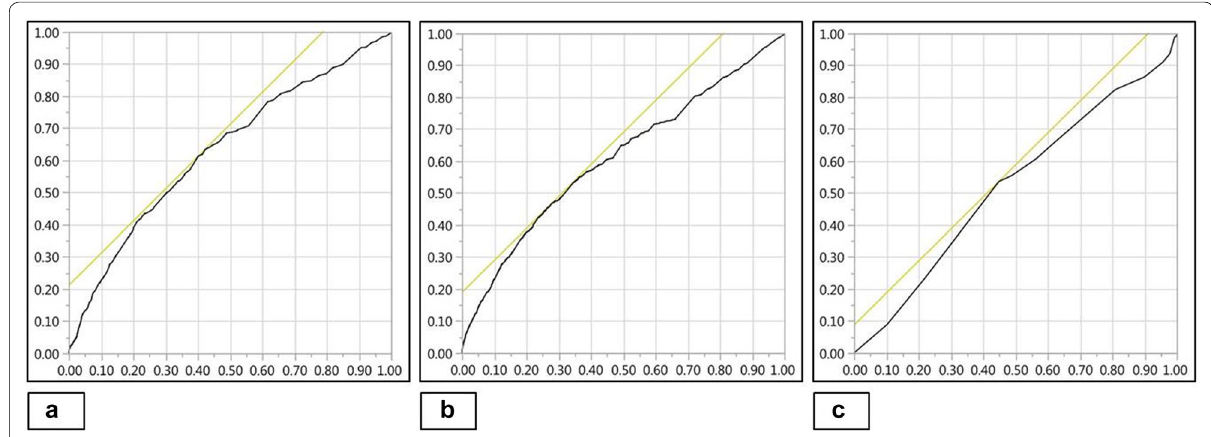
Fig. 3 Discrimination of vasoactive scoring systems for 28-day mortality. AUROC curve for log 10 NEE log